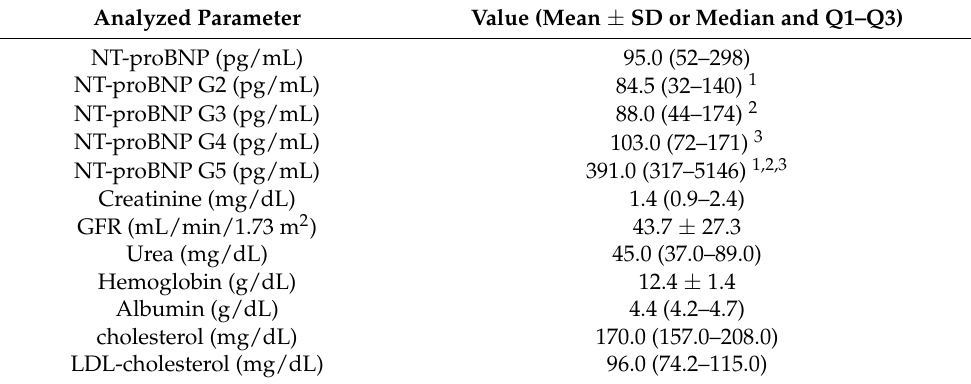
Table 2. NT-pro BNP and biochemical characteristics of the study group (NT-proBNP—N-terminal pro-brain natriuretic